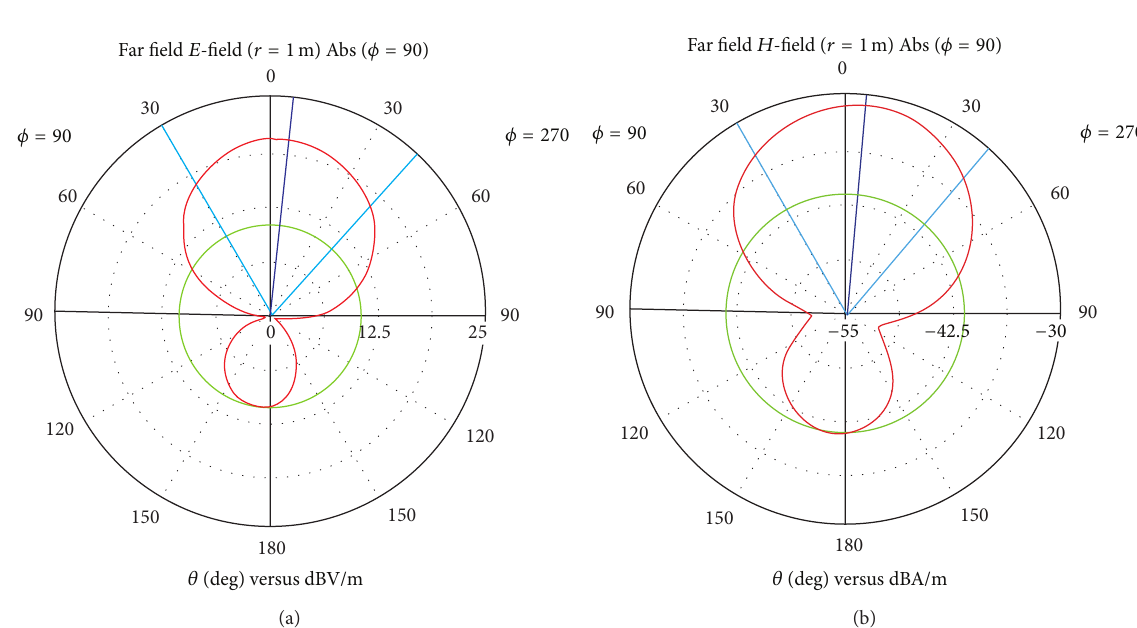
Figure 7: Third stage (final) of proposed antenna. (a) E -field and (b) H